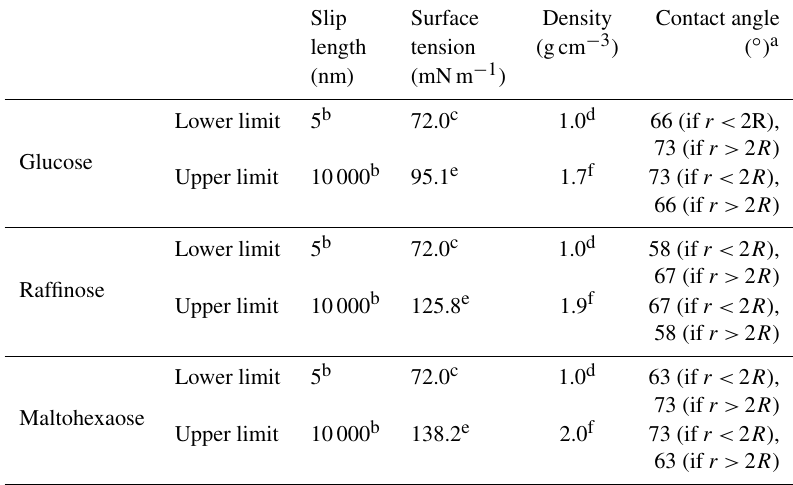
Table 2. Physical parameters used in COMSOL Multiphysics simulations for cases where flow was observed in the poke-and-flow experi- ments. R and r indicate the radius of a tube and the radius of an inner hole,